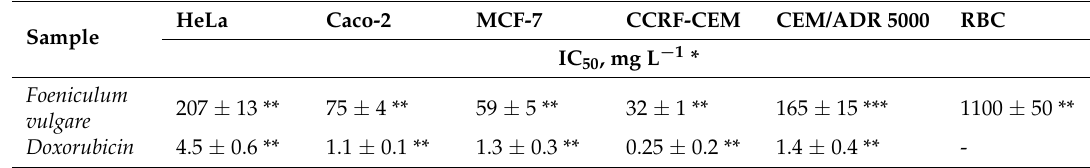
Table 3. Cytotoxicity of the essential oil of Foeniculum vulgare